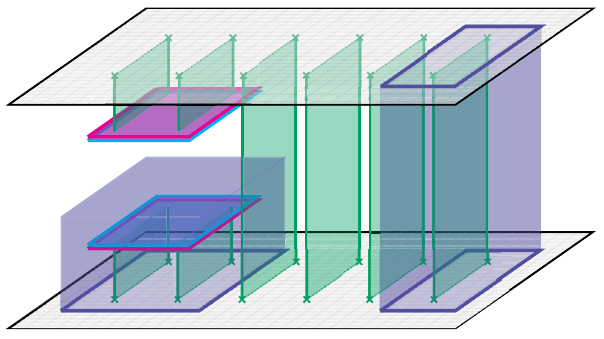
FIG. 21. Teleporting the set of twists T P to measure X 2 ∈ P n . The four twists enclosed by the X 2 loop operator are teleported to a later time slice. Depicted is a logical membrane M X 2 , I whose outcome gives the logical X 2 measurement outcome. As shown by an example primal membrane on the right twist pair, Pauli operators that commute with the measured operator are